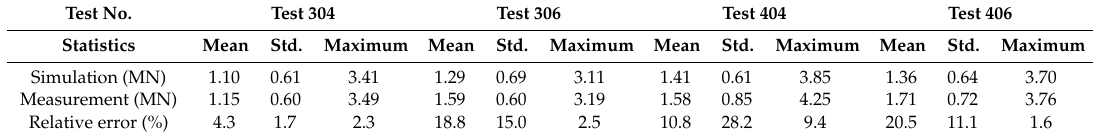
Figure 19. Time history of ice force from the measurement and simulation for test 406. Table 6. Comparison of the maximum ice load from the model test and simulation.